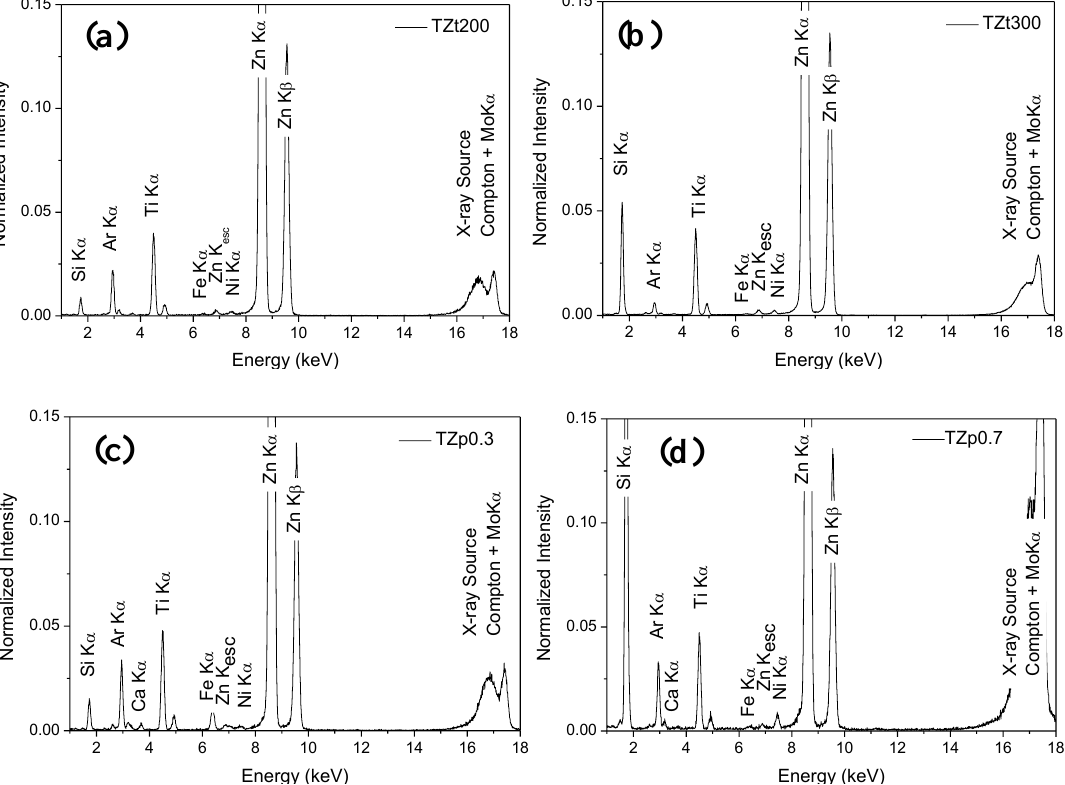
Figure 2. Qualitative total-reflection X-ray fluorescence (TXRF) spectra of Ti-doped ZnO (TZO) thin films with different annealing conditions and normalized to Zn Kα signal. ( a ) TA at 200 °C, ( b ) TA at 300 °C, ( c ) MwPA at 0.3 mbar and ( d ) MwPA at 0.7 mbar.